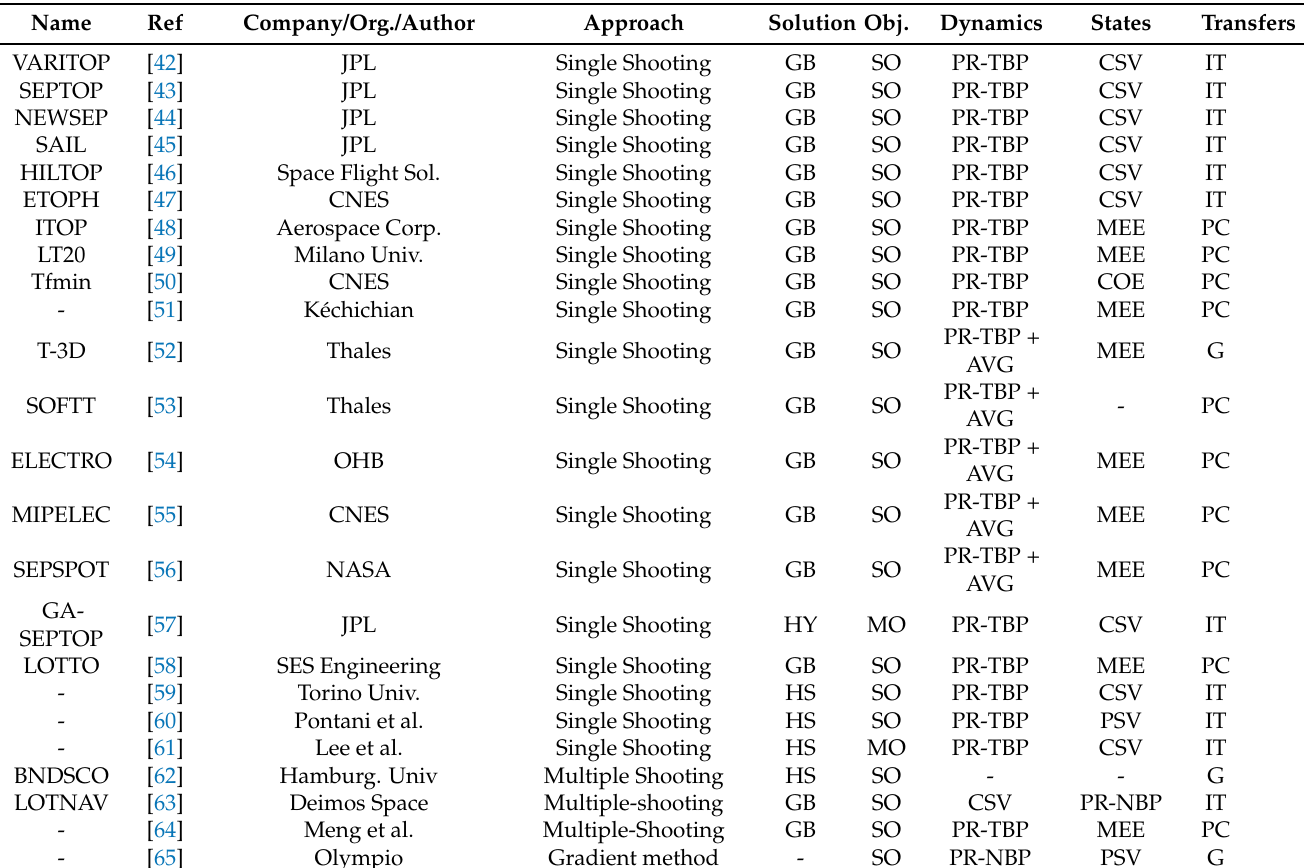
Table 1. Representative Tools Implementing Indirect Methods for Low-Thrust Trajectory